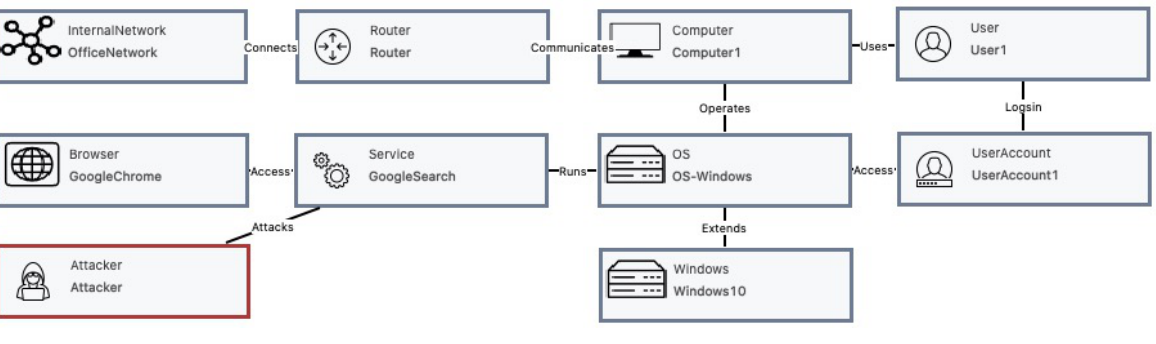
Figure 10. Simplified system